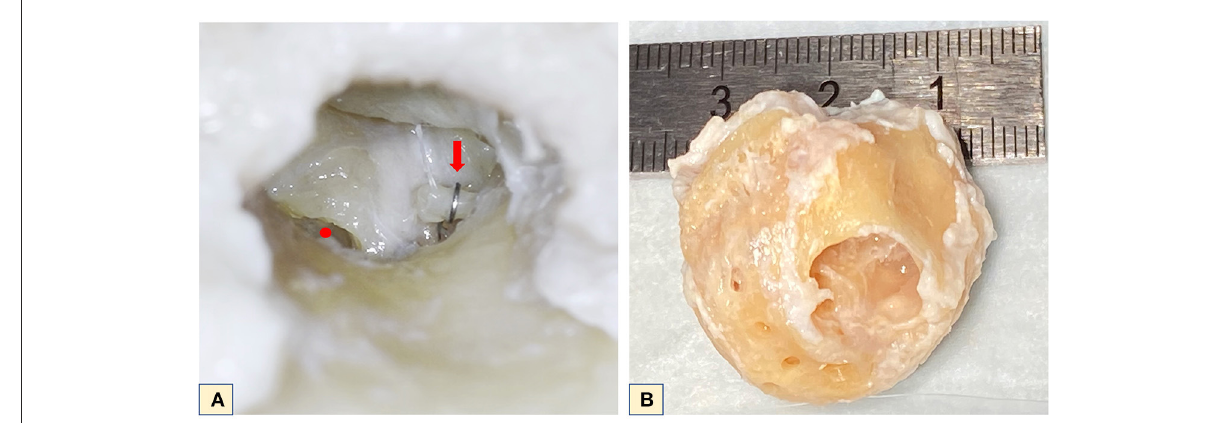
FIGURE1 (A) Microscopic middle ear view of the left cochlea. Red dot–round window; red arrow–stapes prosthesis positioned on the long process of the incus. (B) Final cochlea size after refinement for